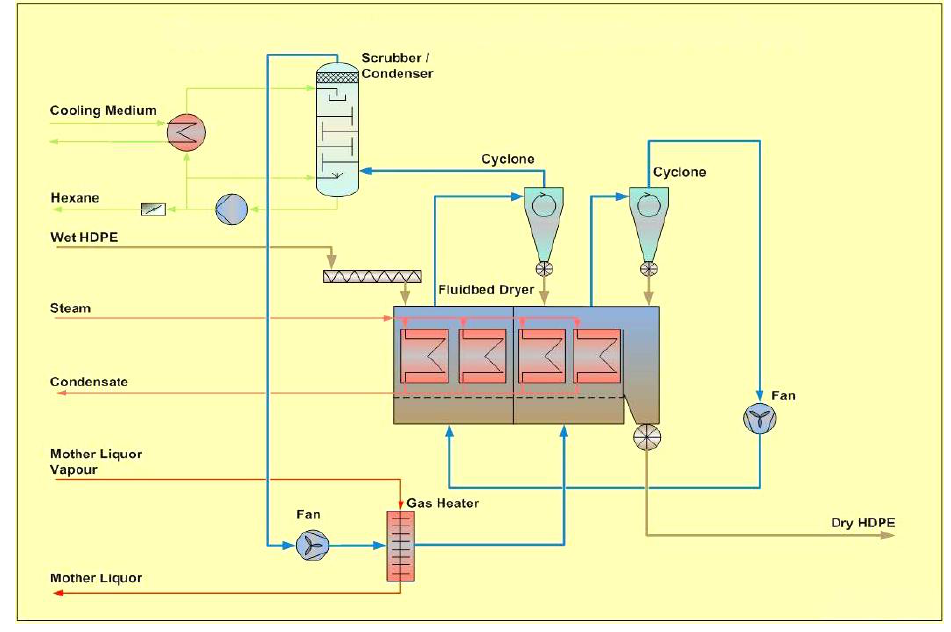
Figure 2. Industrial fluid bed dryer and double-cyclone for drying process.